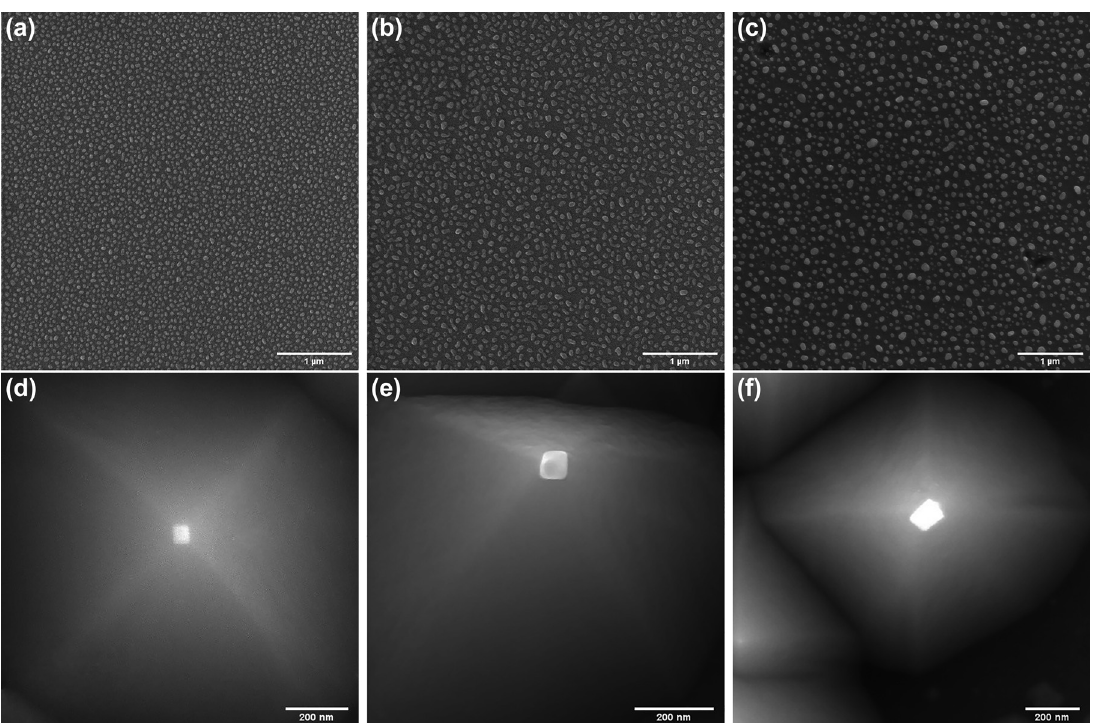
Figure 2: Catalyst nanoparticles and their typical underlying silicon nanotips generated for the three initial catalyst depositions. 5 nm (a, d), 10 nm (b, e), and 15 nm (c, f) thick deposited Ni-layer, 2 min IR irradiation with the power of 30 W (a), 40 W (b), and 50 W (c), and anisotropic etching in a 20% KOH solution at 65 ◦ C for 3 min (d), 4 min (e), and 5 min (f) are